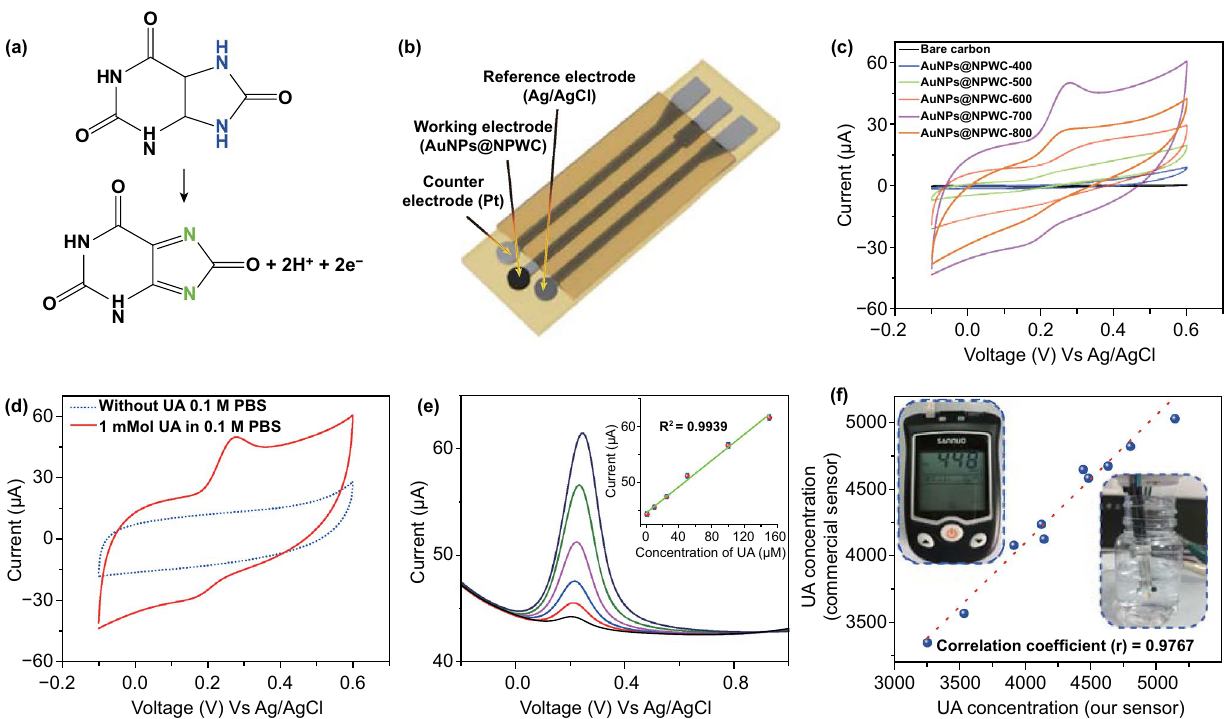
Fig. 5 General strategy and response of UA sensor: a Reaction scheme showing non-enzymatic electrocatalytic UA oxidation reaction. b Sche- matic illustration of three-electrode flexible strip-based sensor. c Cyclic voltammograms of 1.0 mM UA in 0.1 M PBS (pH = 7) using different electrodes. d Cyclic voltammograms of 1.0 mM UA in 0.1 M PBS (pH = 7) and without UA only 0.1 M PBS (pH = 7) using AuNPs@NPWC- 700 modified sensor. e DPV curves of AuNPs@NPWC-700 electrode in different concentrations of UA (1–150 µM) containing 0.1 M PBS (pH = 7) solution, the plot of oxidation currents versus the concentration of UA (inset). f Correlation between the developed biosensor and the commercial standard UA